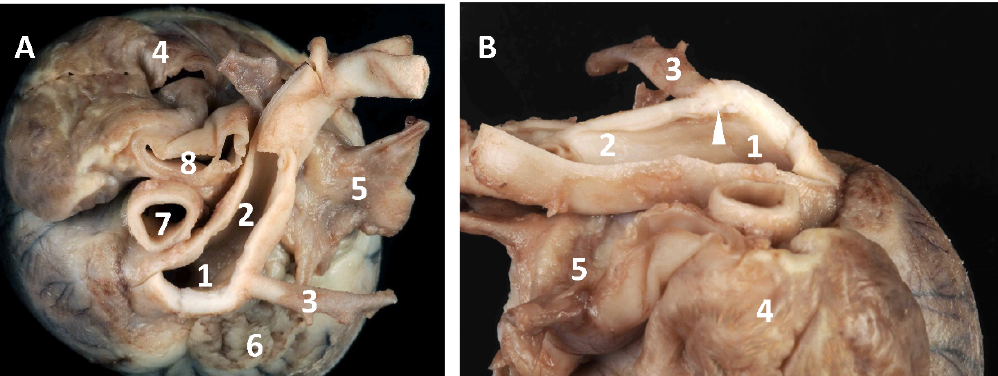
Figure 3. Gross pathology: ( A ) Dorsal view of the heart base showing severe dilatation of the pulmonary trunk (1) and right pulmonary branch (2), severe hypotrophy of the left pulmonary branch (3), and severe dilatation of the right atrium and auricle (4); 5: left atrium with pulmonary veins; 6: left auricle; 7: ascending aorta; 8: cranial vena cava; ( B ) Right lateral view of the heart base after opening of the pulmonary artery showing atresia of the origin of the left branch (arrow). The same numbers identify the same structures as in Figure 2A.